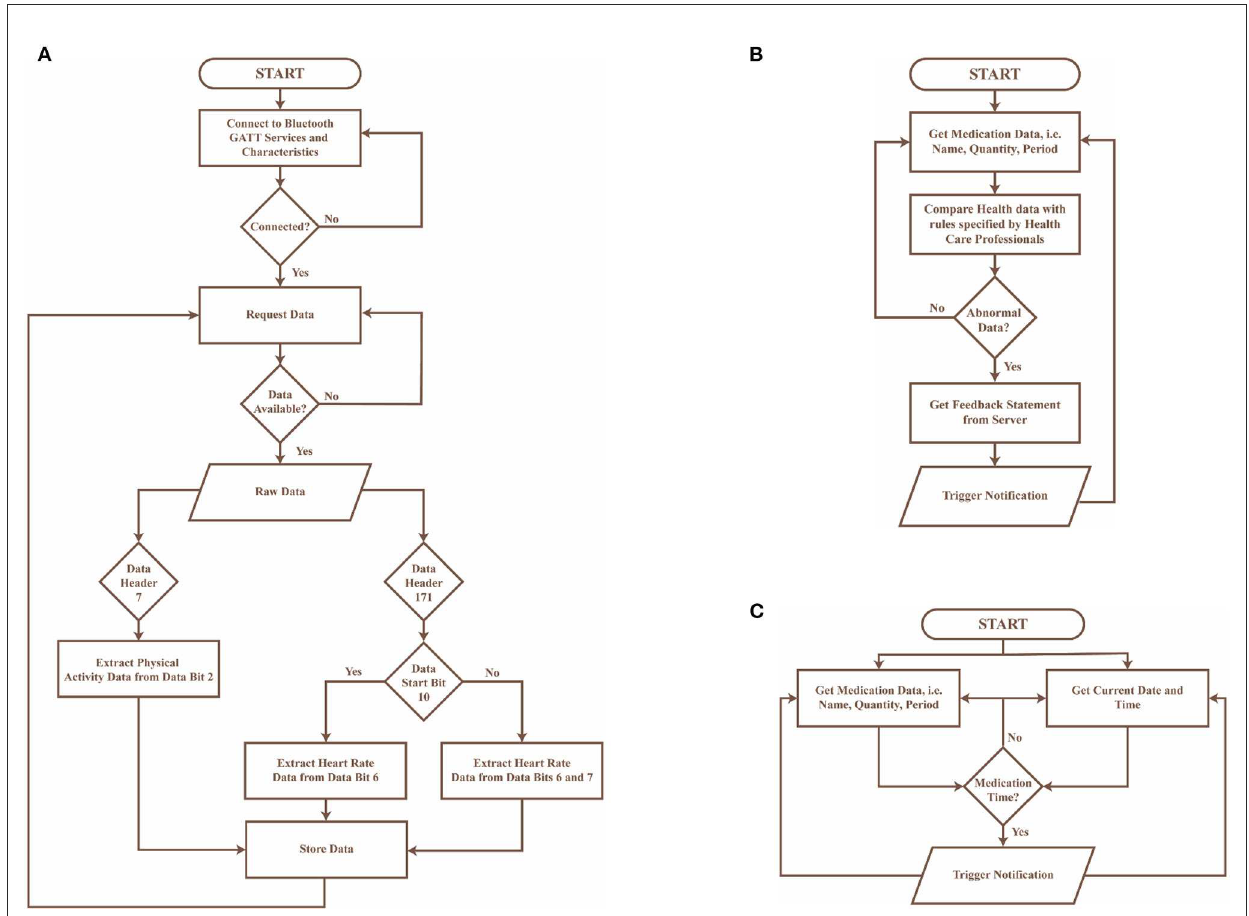
FIGURE6 Flowcharts of algorithms implemented in the control layer of the mHealth app, where (A) presents the preprocessing algorithm for data collected from the bluetooth wearable device, (B) describes the algorithm to provide automated feedback to the user in the form of notifications, and (C) represents the algorithm used to notify the user about their medication